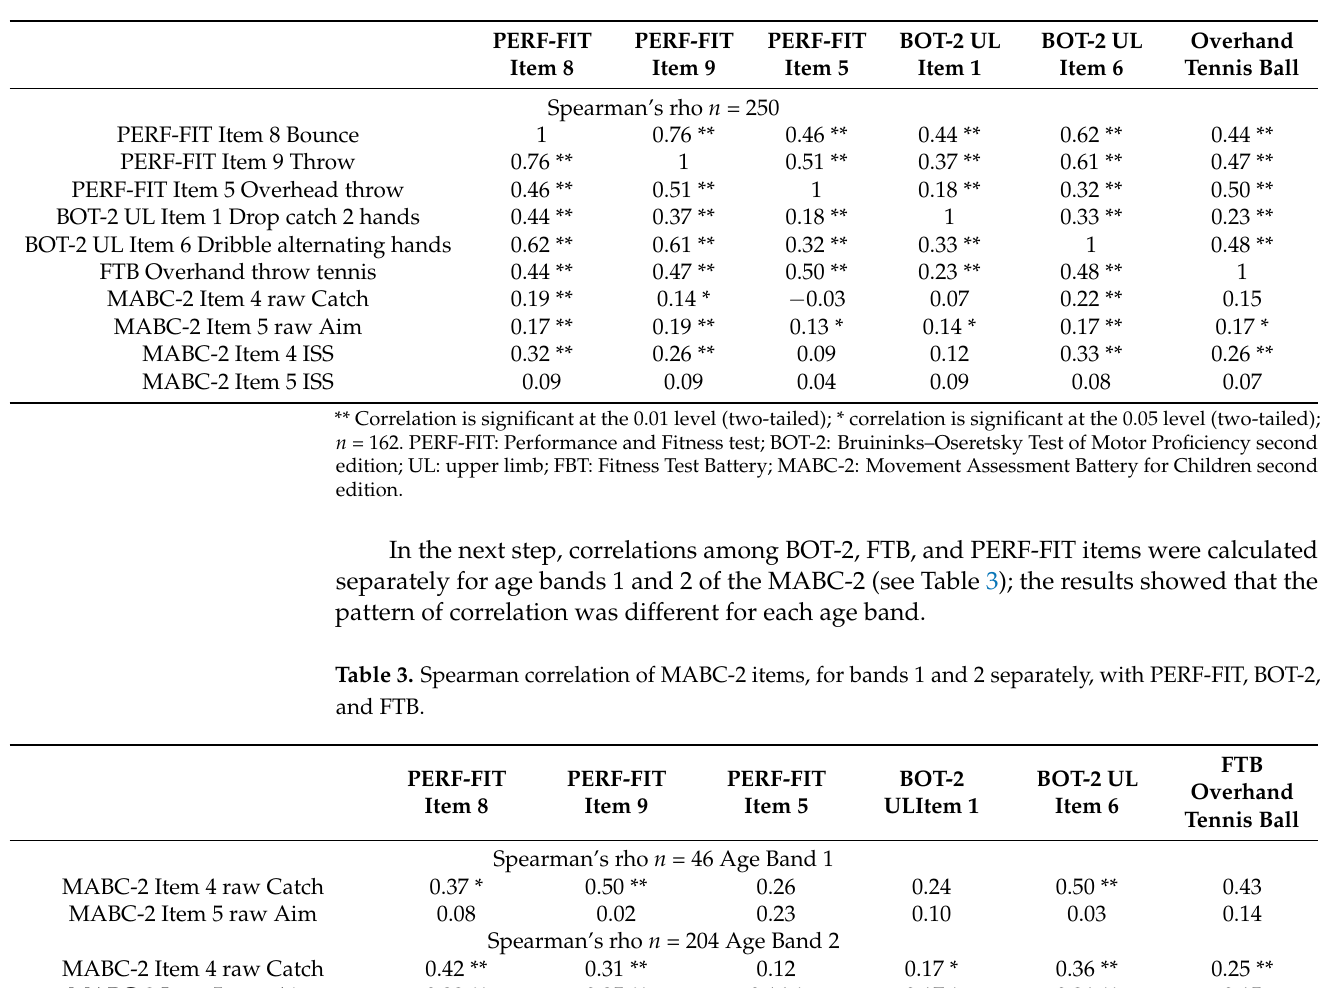
Table 2. Spearman correlation among PERF-FIT, MABC-2, FBT, Fitness Test Battery, and BOT-2.